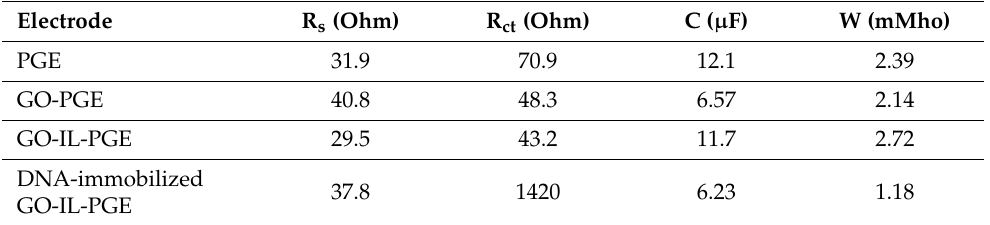
Figure 4. Nyquist diagrams of ( a ) PGE, ( b ) GO-PGE, ( c ) GO-IL-PGE, and ( d ) 100 µg/mL fsDNA immobilized GO-IL-PGE. Inset: The closer view of the Nyquist diagrams. Table 3. EIS response parameters obtained after curve fit of the Nyquist diagrams presented in Figure 4 using Randles